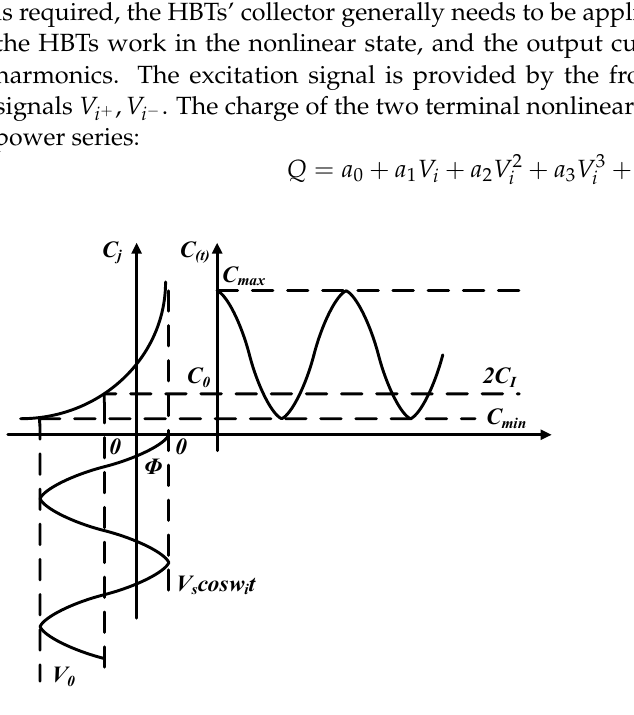
Figure 4. Junction capacitance curve with nonlinearity.